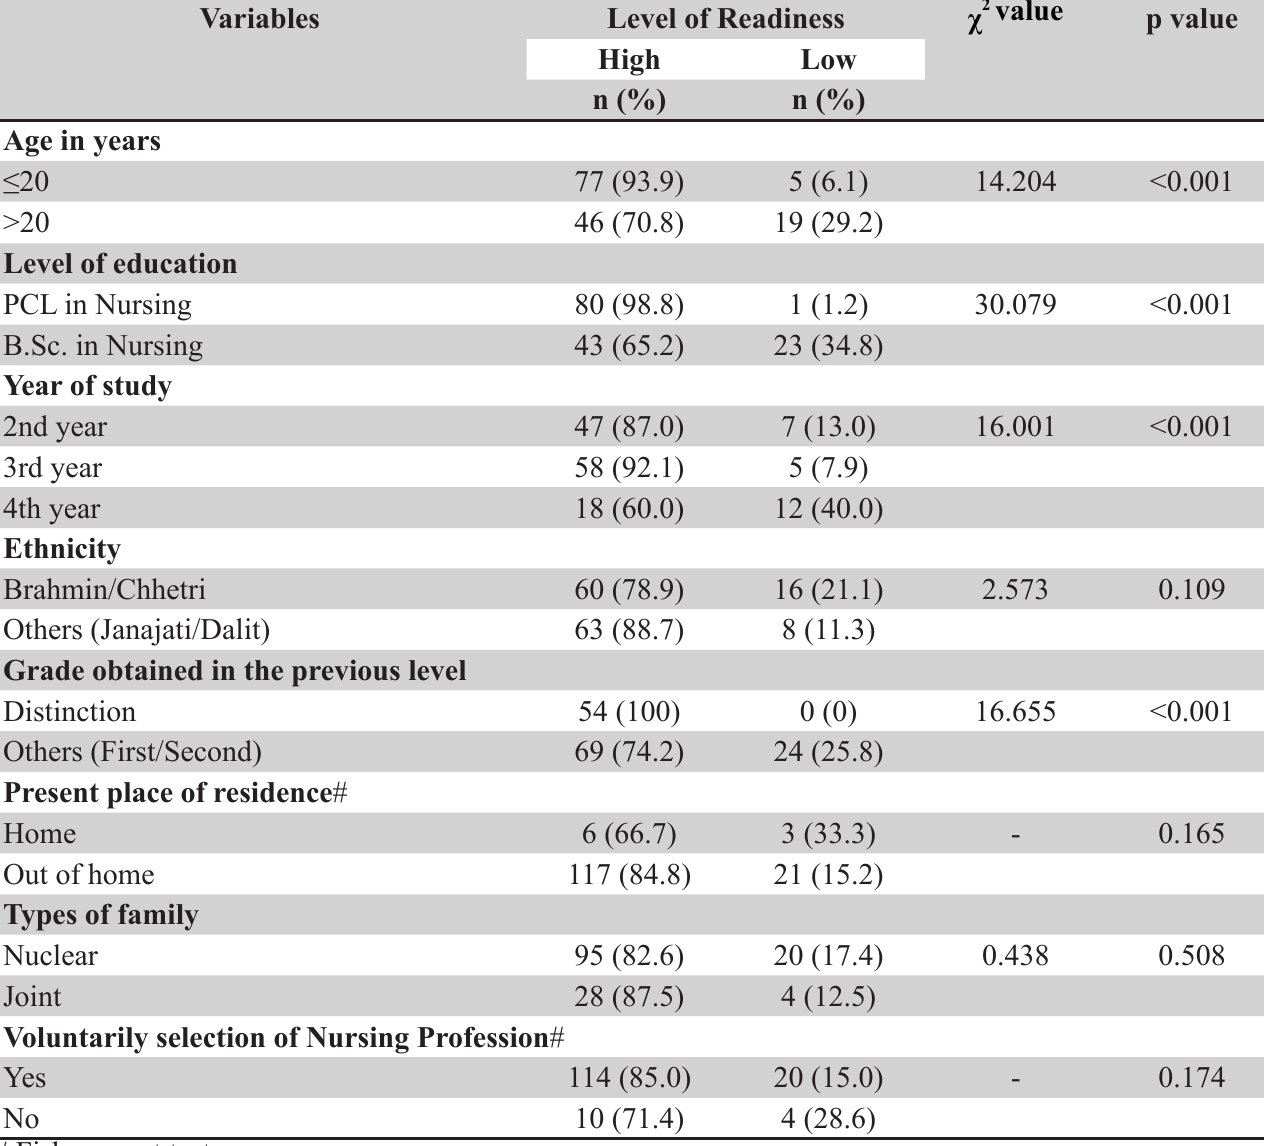
Table 4. Associations between SDLR and Selected Demographic Variables